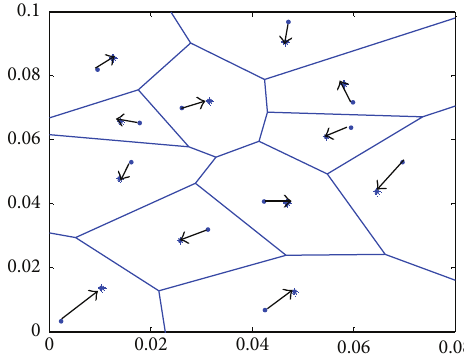
Figure 1: Snapshot of Centroid-Directed Potential Field.